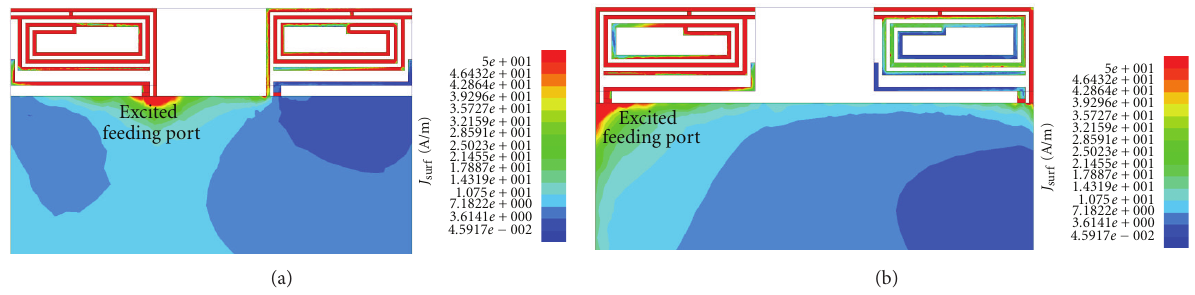
Figure 8: Current distributions at 0.752 GHz: (a) type I and (b) type II.